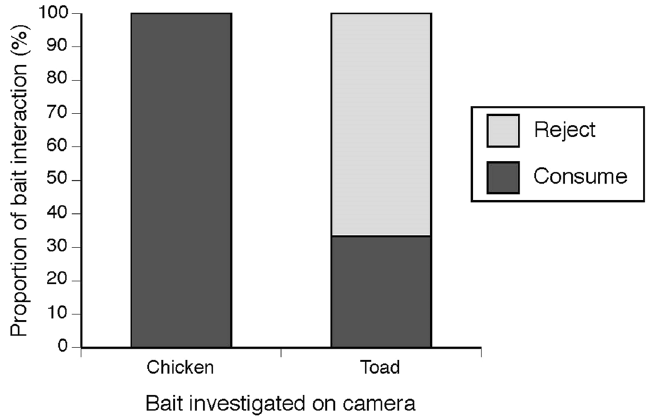
Figure 3. Analysis of reactions (consume or reject) of toad-sympatric populations of freshwater crocodiles ( Crocodylus johnstoni ) to chicken and cane toad baits, using data collected by remotely-triggered video cameras. Rates of consumption of toad versus chicken baits were equal in toad naïve populations (not shown).